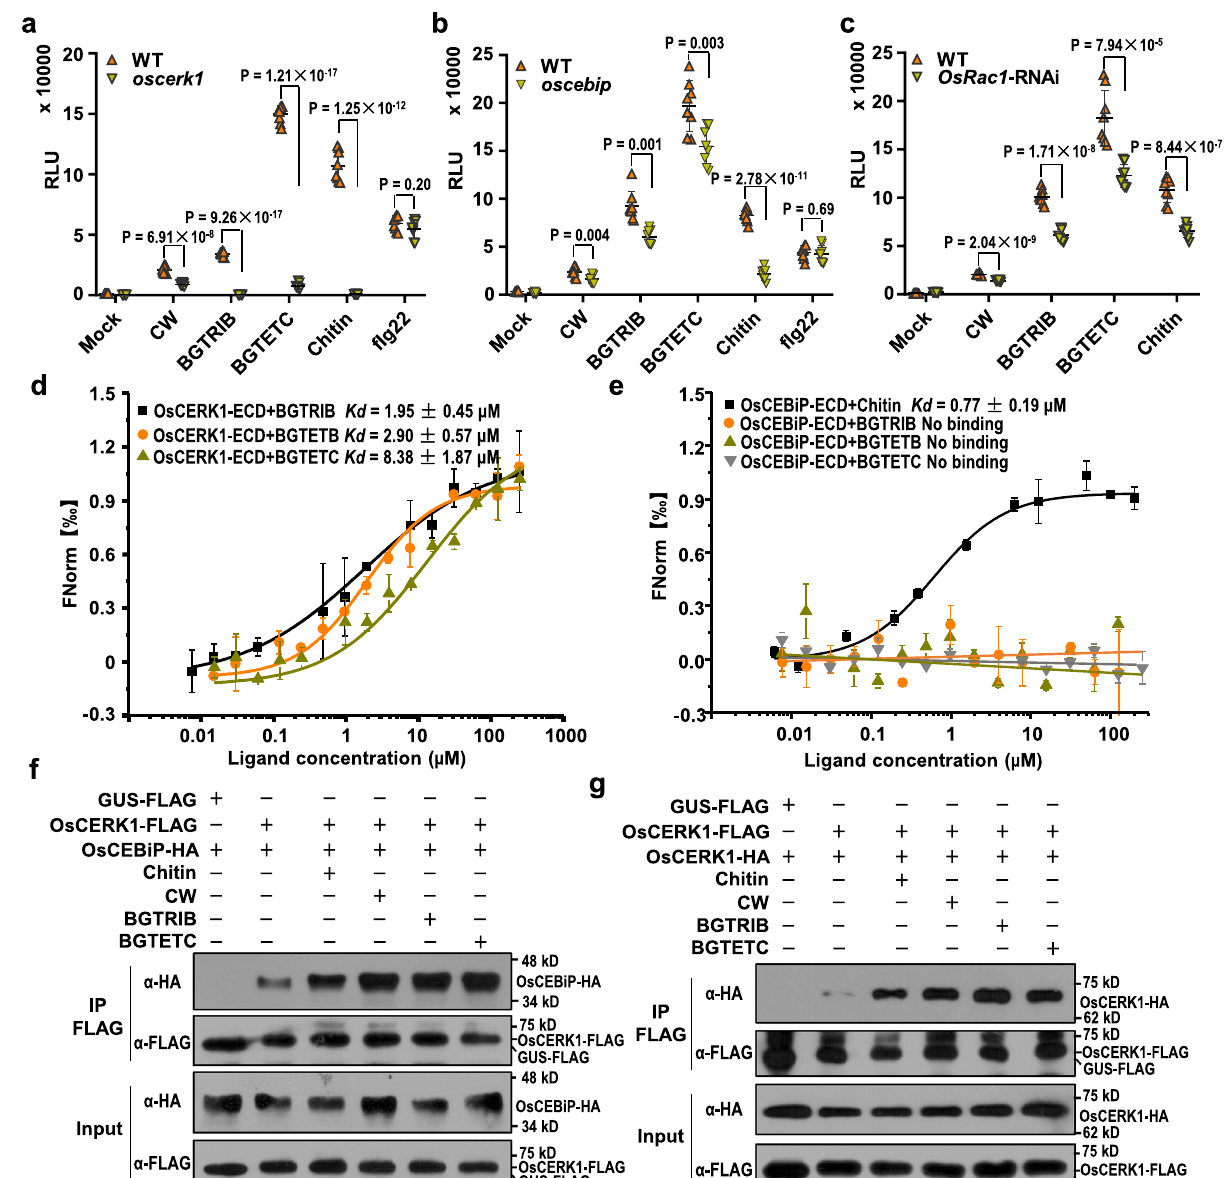
Fig. 5 The rice cell wall-derived speci fi c oligosaccharides are perceived by OsCERK1. a ROS burst induced by rice cell wall-derived speci fi c oligosaccharides is abolished in oscerk1 mutant. The WT and oscerk1 suspension cells were elicited with sterile water (Mock), fi ltered supernatants (1/100, v/v) of MoCel12A-hydrolyzed rice cell walls (CW), 10 μ M BGTRIB, 10 μ M BGTETC, and 5 μ g/ml chitin in ROS burst assays, respectively. fl g22 (100 nM) served as a positive control. Values are means ± SD ( n = 8 biological replicates). RLU, relative light units. b ROS generation induced by rice cell wall-derived speci fi c oligosaccharides in oscebip mutant. Others are as in (a). c ROS generation induced by rice cell wall-derived speci fi c oligosaccharides in OsRac1 - RNAi plants. Others are as in ( a ). d Microscale thermophoresis (MST) assays show the binding of OsCERK1-ECD with the speci fi c oligosaccharides. The solid curve is the fi t of the data points to the standard K d - fi t function. K d , dissociation constant. Bars represent ± SD ( n = 3 biological replicates). e MST assays show that OsCEBiP-ECD does not bind the oligosaccharides. Others are as in ( d ). f BGTRIB and BGTETC triggered heterodimerization of OsCERK1 and OsCEBiP in rice. OsCERK1-FLAG and OsCEBiP-HA were co-expressed in WT rice protoplasts. GUS-FLAG served as a negative control. The protoplasts were treated with 5 ug/ml chitin, fi ltered supernatants (1/100, v/v) of MoCel12A-hydrolyzed rice cell walls (CW), 10 μ M BGTRIB and 10 μ M BGTETC for 15 min. Co-immunoprecipitation was performed using anti-FLAG antibody and subjected to immunoblot analysis with anti-FLAG or anti-HA antibody as indicated. The experiment was repeated three times with similar results. g BGTRIB and BGTETC triggered OsCERK1 dimerization in rice. FLAG- and HA- tagged OsCERK1 were co-expressed in WT rice protoplasts. Others are as in ( f